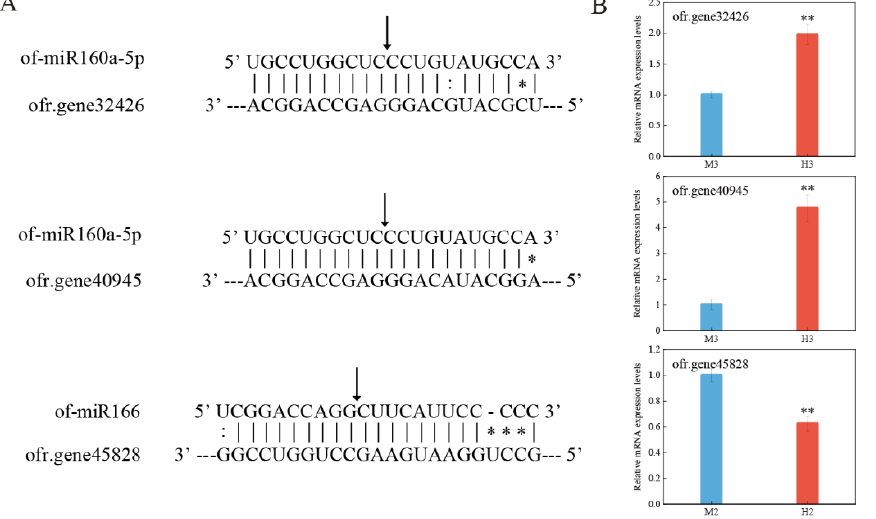
Figure 6. 5 ′ RLM-RACE experiment of miRNA cleavage sites and quantitative verification of target genes. ( A ) Schematic diagram of target gene cleavage sites by miRNAs. The arrows indicate the detected cleavage sites, * indicates mismatches and : indicates G – U mismatches. ( B ) Relative expression levels of target genes. Asterisks indicate significant differences, as determined by Student’s t -test (** p < 0.01).